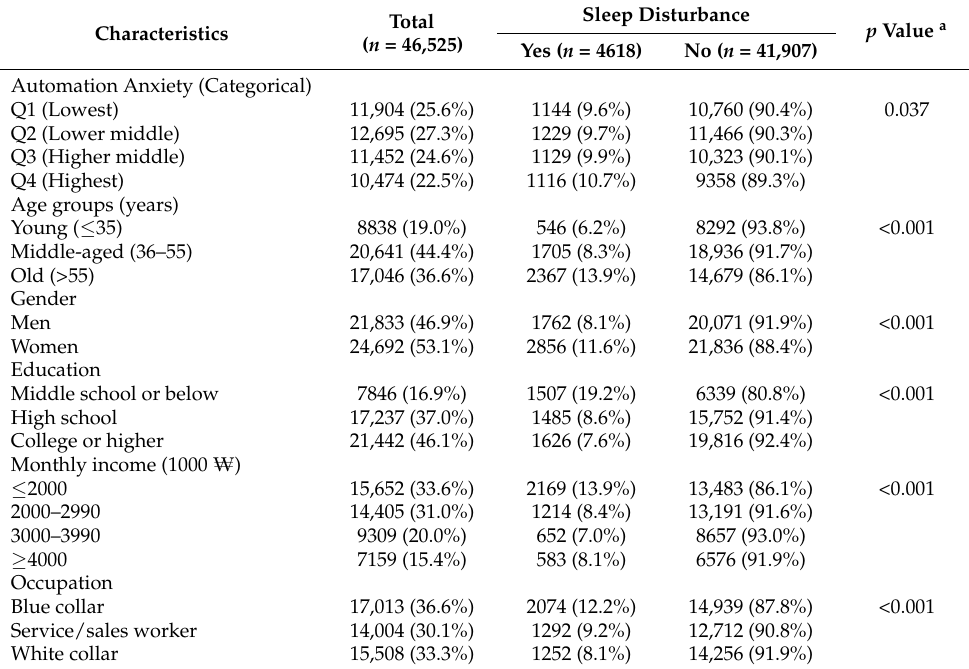
Table 1. Baseline characteristics and prevalence of sleep disturbance among study